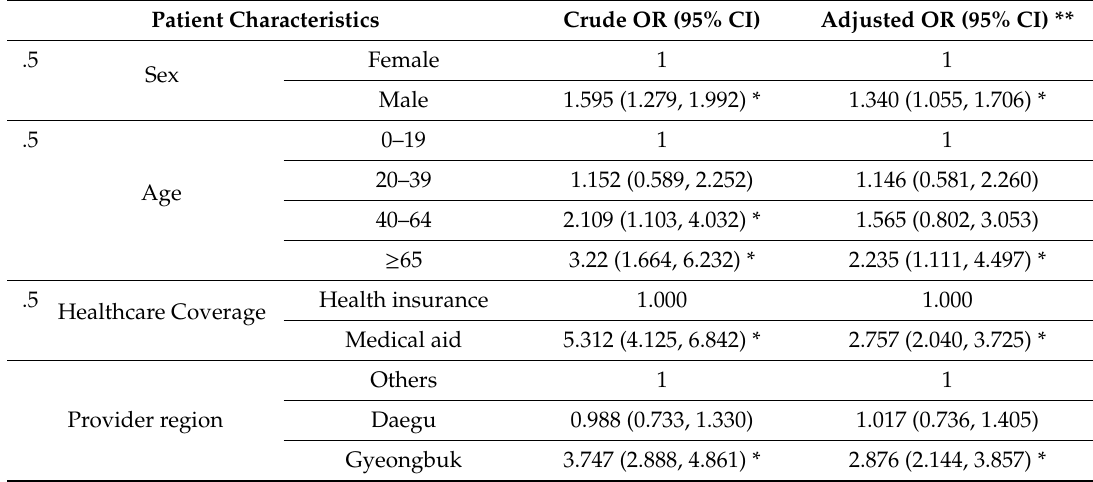
Table 2. Logistic regression results for readmission of COVID-19